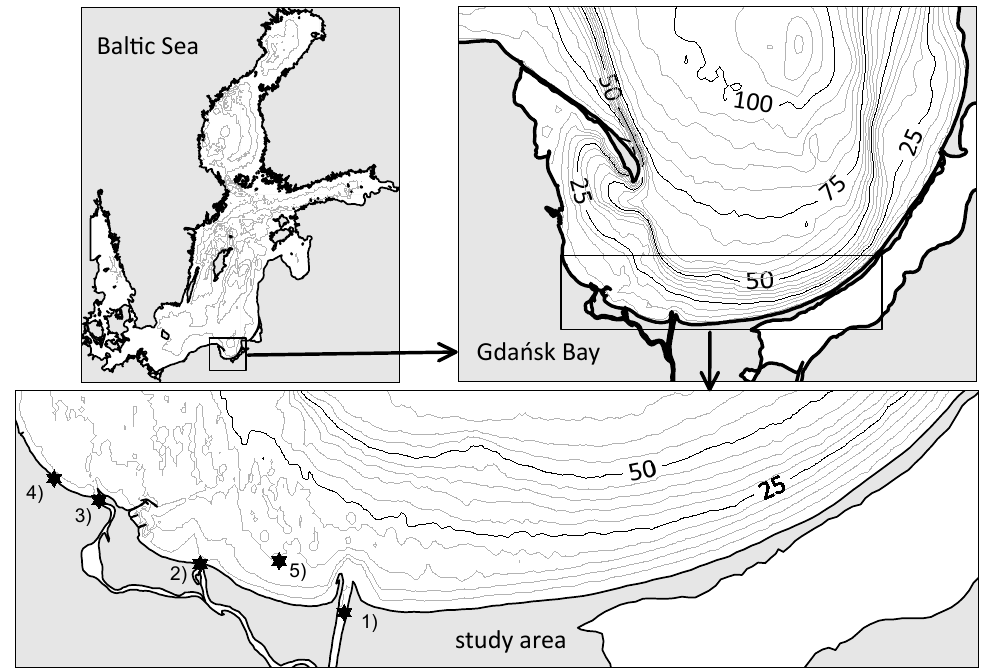
Figure 3. Bathymetry of the study area—the southern part of the Gulf of Gda ń sk and areas modeled in lower resolution: the Baltic Sea and the Gulf of Gda ń sk. Indicated locations are: (1) the mouth of the Vistula River, (2) the mouth of the Wis ł a Ś mia ł a River, (3) the Martwa Wis ł a River, (4) the Jelitkowski Stream, and (5) the outlet from the collector of the Gda ń sk Wschód WWTP. Table 2. Failures of the wastewater network that have occurred in the last four years during the late spring and summer